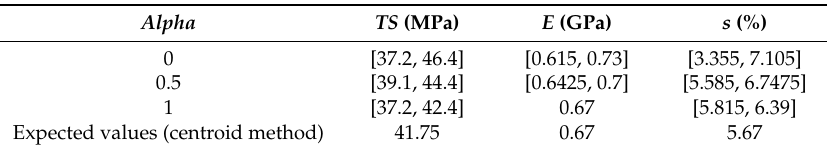
Table 3. Possibilistic uncertainties.